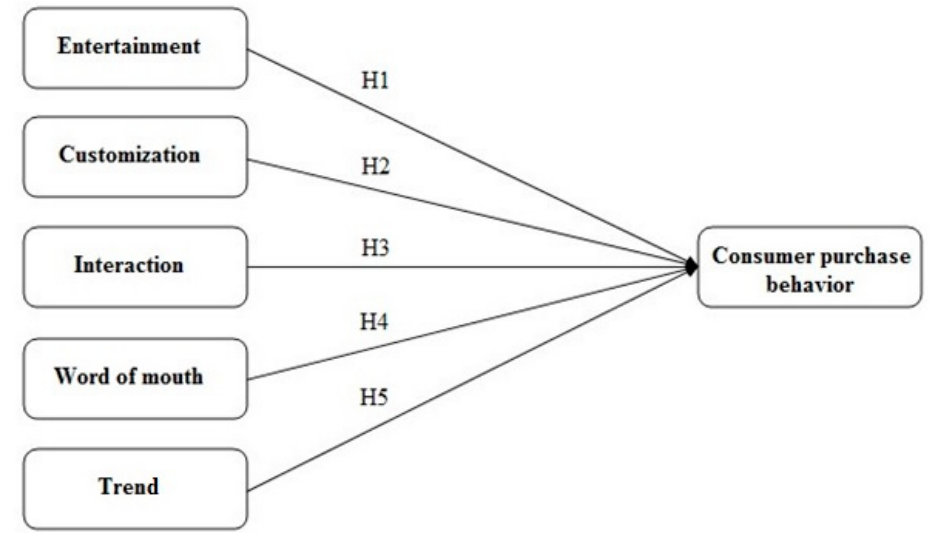
Figure 1. Theoretical model (five dimensions of social network marketing on CPB).